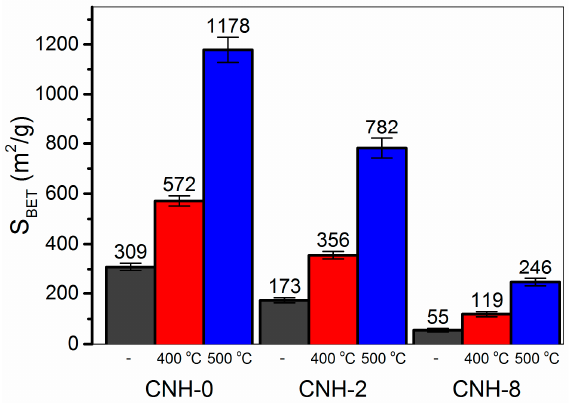
Figure 4. BET specific surface area of initial and thermally oxidized CNHs.